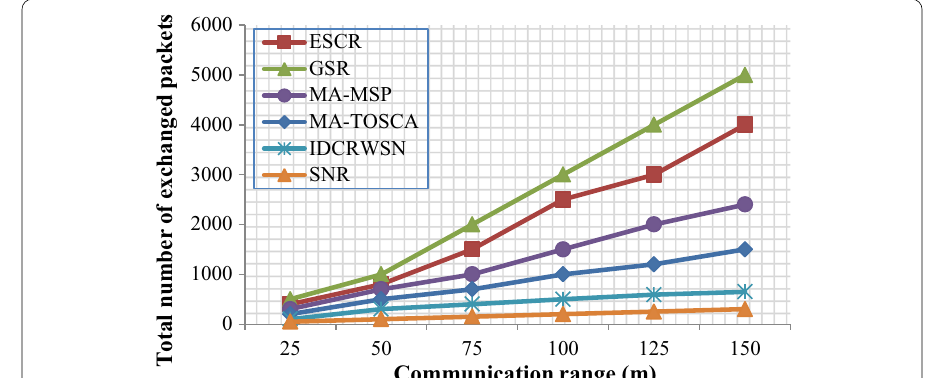
Fig. 12 Total number of exchanged